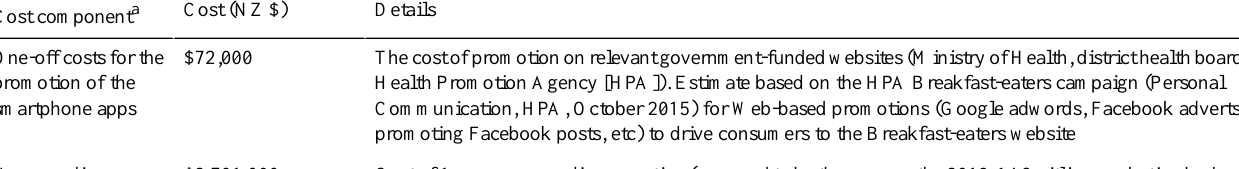
Table 3. Costs associated with the smartphone app for weight loss promotion intervention. DetailsCost (NZ $)Cost component